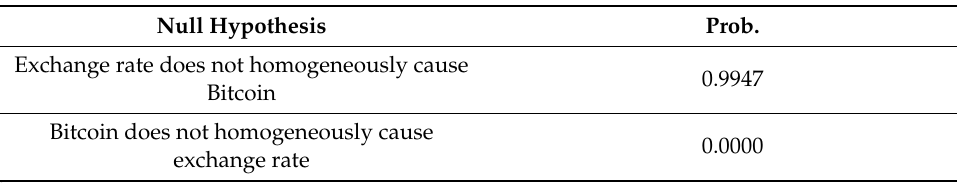
Table A1. Dumitrescu and Hurlin (2012) causality